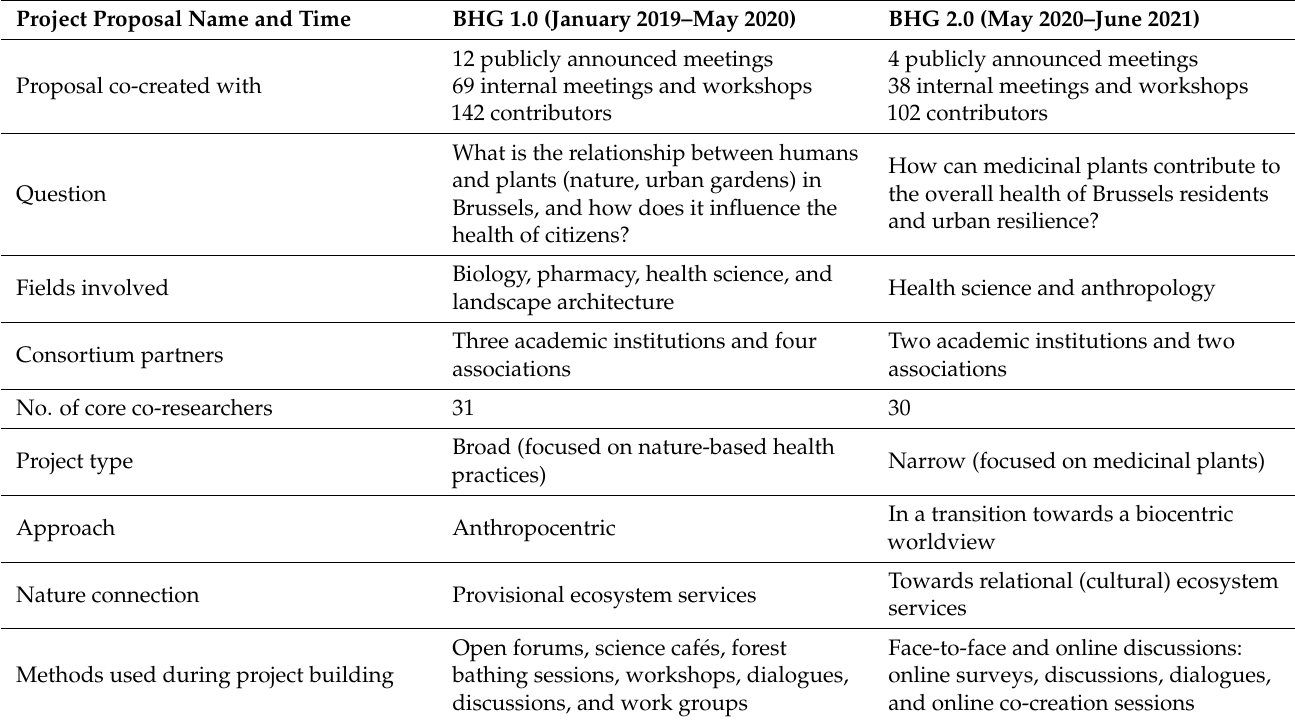
Table 1. Summary of the BHG research project